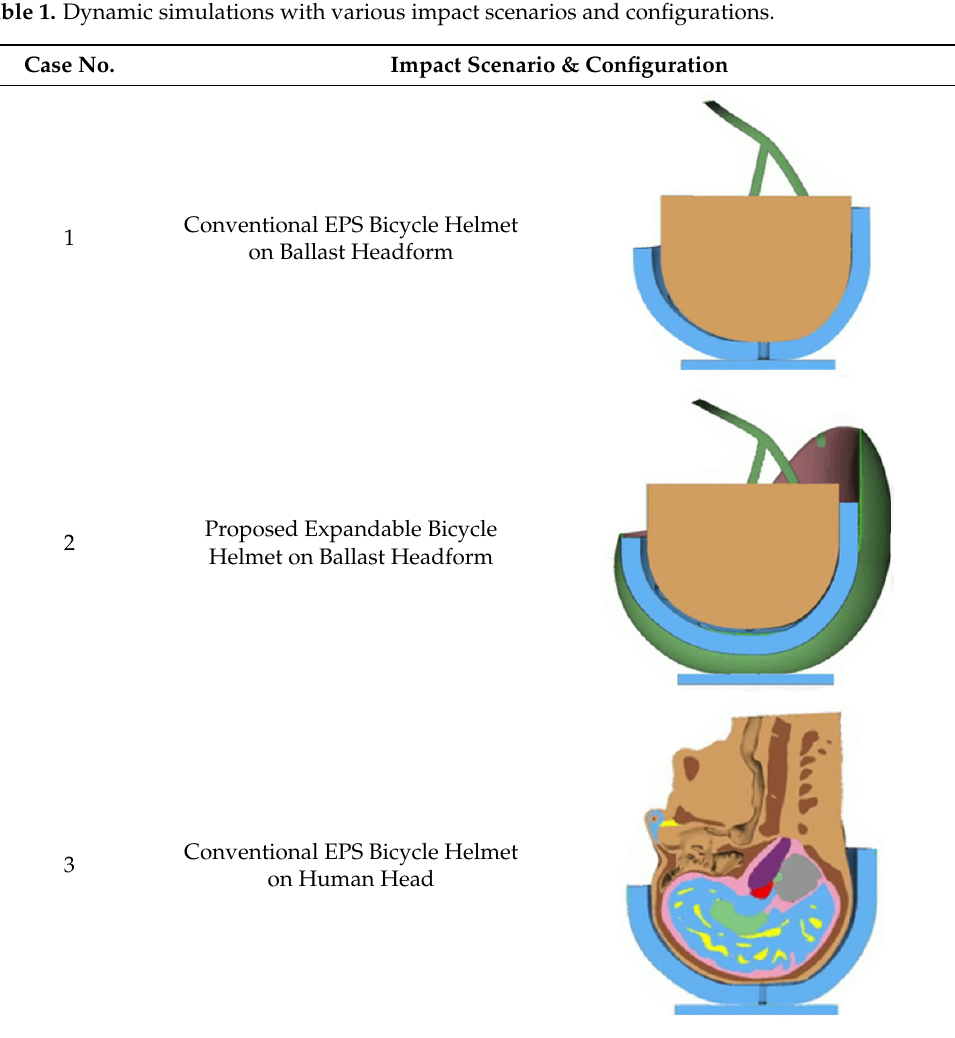
Table 1. Dynamic simulations with various impact scenarios and